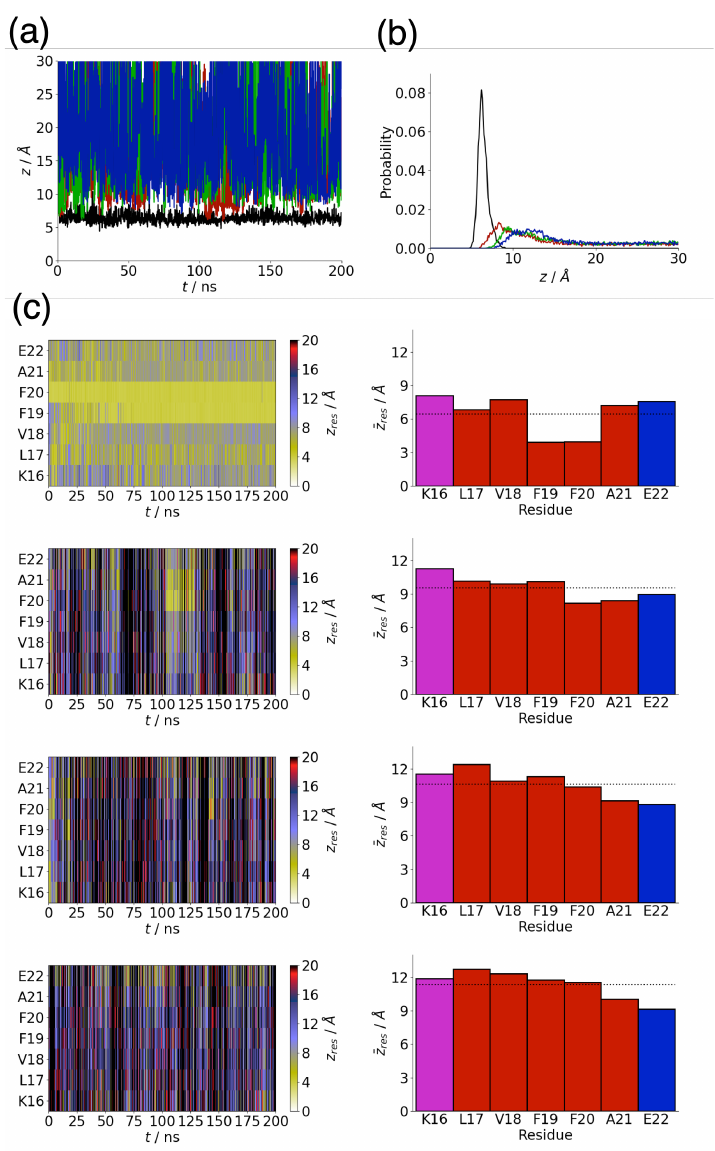
Figure 1. ( a ) A β (16–22) centre-of-mass position. Black, red, green, and blue lines denote Au111, Au100, Ag111, and Ag100, respectively. ( b ) probability histograms (averaged over last 100 ns of simulations) for A β (16–22) on Au111 (black), Au100 (red), Ag111 (green), and Ag100 (blue); ( c ) residue centre-of-mass-surface separations (left) and average residue centre-of-mass-surface separations (right). From top-to-bottom, Au111, Au100, Ag111, and Ag100. In the left hand panel, colours denote separation (as denoted in the colour bar). In the right hand panel, red, blue, and magenta denote hydrophobic, negatively-charged, and positively-charged